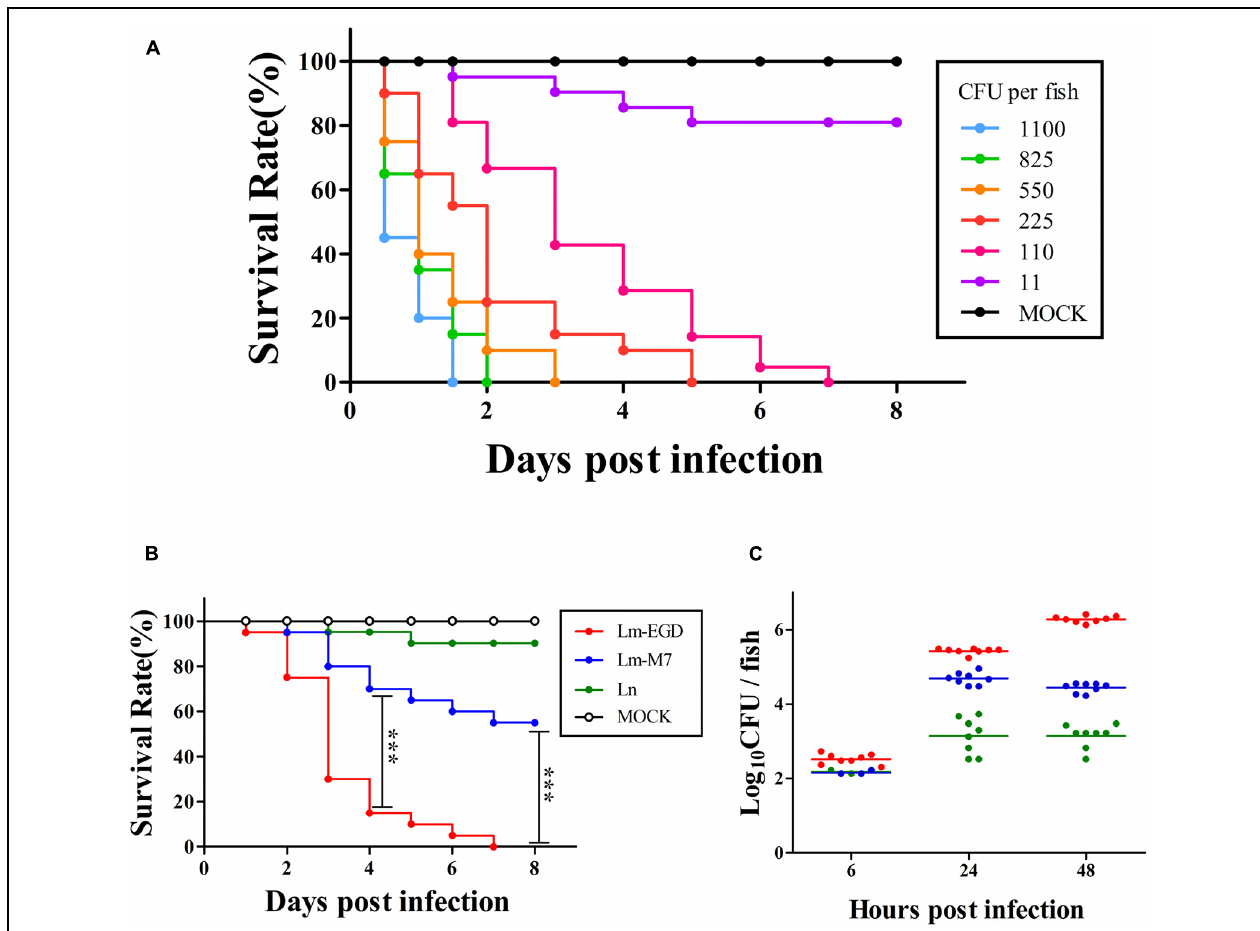
FIGURE 7 | Infection of germ-free zebrafish embryos, via intravenous injection, with graded inocula of L. monocytogenes EGDe (A, % survival with n = 20), or with similar inocula (80–140 CFU on average) of L.